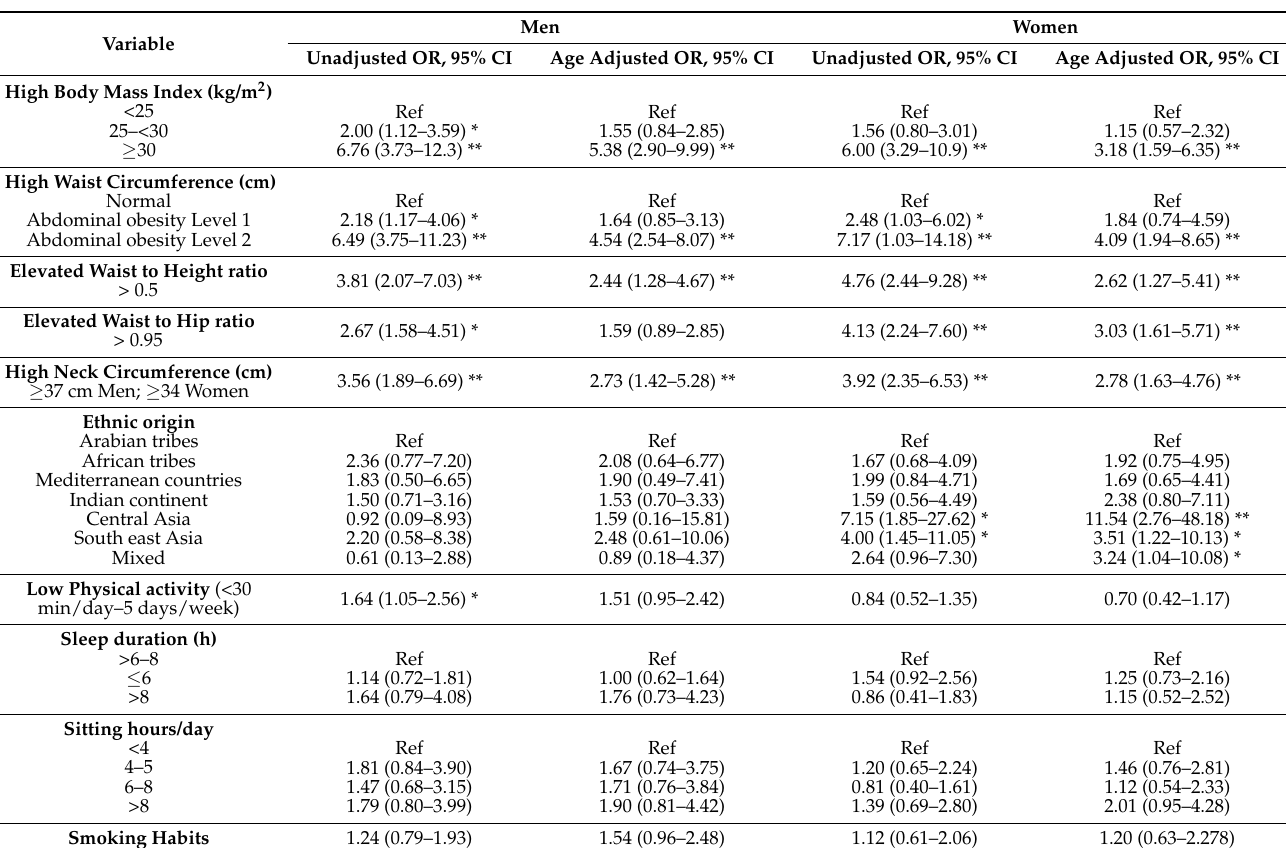
Table 5. Unadjusted and age-adjusted odds ratio (OR), and confidence interval (CI) for anthropometric measurements and lifestyle habits covariates associated with